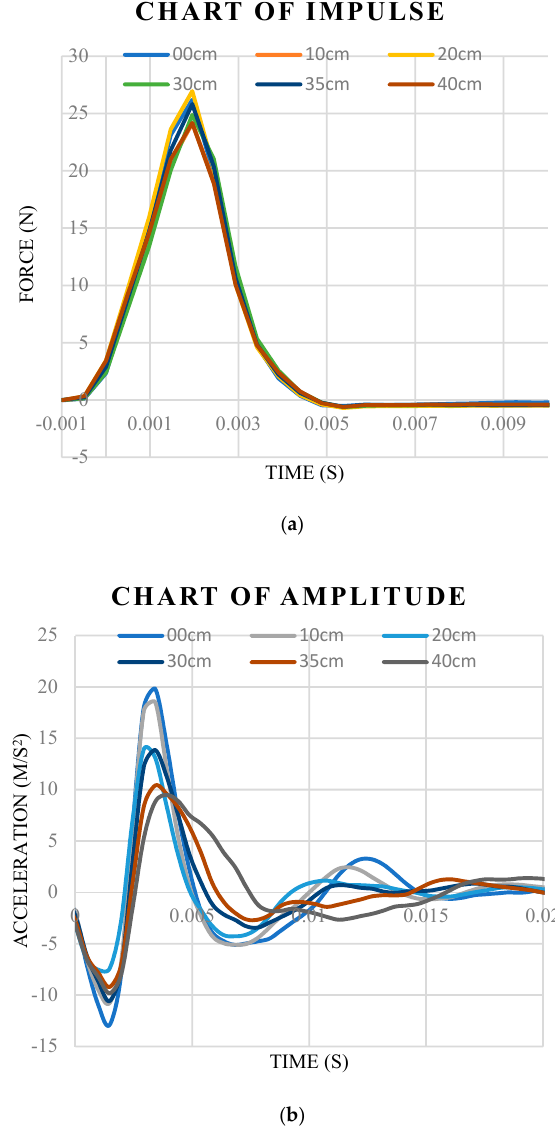
Figure 11. ( a ) Change of impulse; ( b ) change of acceleration.